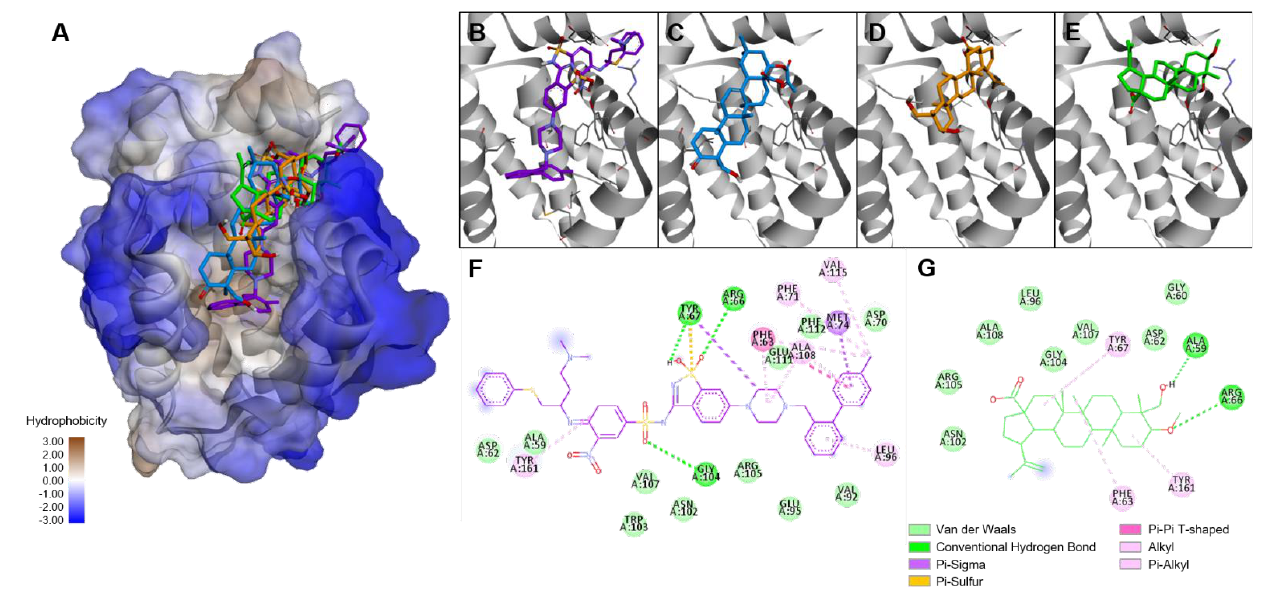
Figure 6. Binding modes of T1m in the BCL− 2 protein. ( A ) Superimposed poses inside inhibitor binding site. Close− up of the binding site with ( B ) co- crystallized inhibitor (Re− docking RMSD: 3.603 Å ), ( C ) icterogenin, ( D ) compound T1, and ( E ) compound T1m . Interactions of BCL− 2 protein with ( F ) co-crystallized inhibitor and ( G ) T1m .